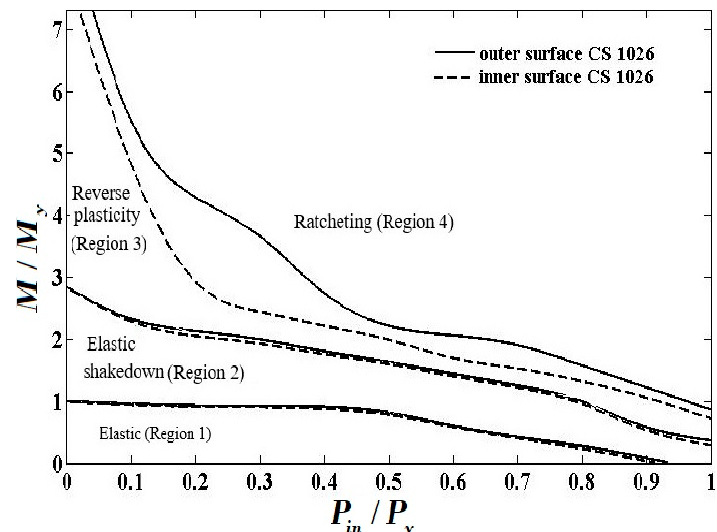
Figure 7. Bree’s diagram for internally pressurized FGM pipe under cyclic bending moment for two different FGM profiles including the inner and outer surfaces made of CS 1026.